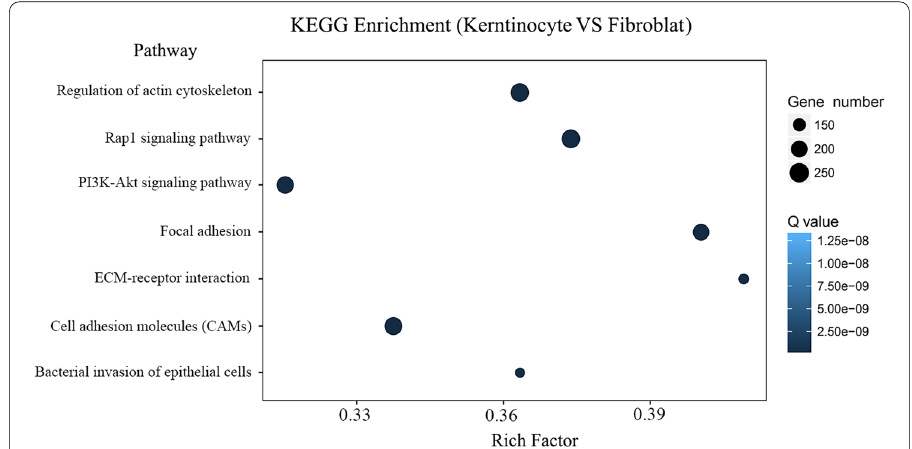
Fig. 4 Scatter plot of KEGG enrichment of differential genes. To investigate the main functional pathway of DEGs, KEGG enrichment analysis was carried out. The vertical axis represents the name of the pathway, the horizontal axis represents the rich factor, and the dot size indicates the number of differentially expressed genes in this pathway. The color of the points corresponds to different Q value ranges. Rich factor refers to the ratio of the number of differential genes (sample number) enriched in the pathway to the number of annotation genes (background number). A greater Rich factor value indicates greater